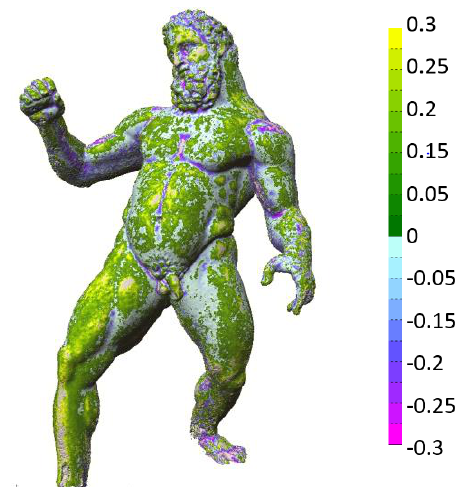
Figure 10. Comparison map [mm] between two different reconstructions of the object.